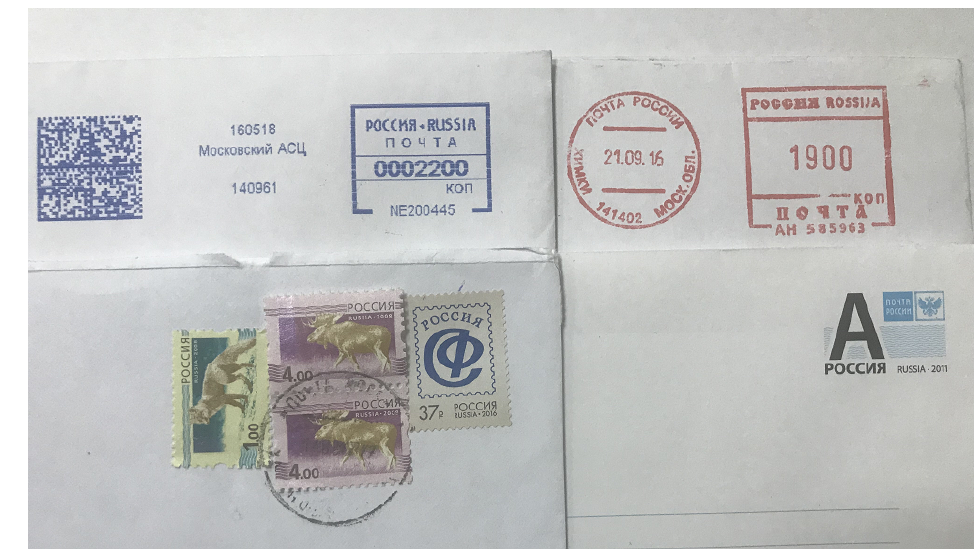
Figure 1. Russian post indicium types. Top left: modern meter stamp; top right: out of date meter stamp; bottom left: postage stamps; bottom right: printed postage